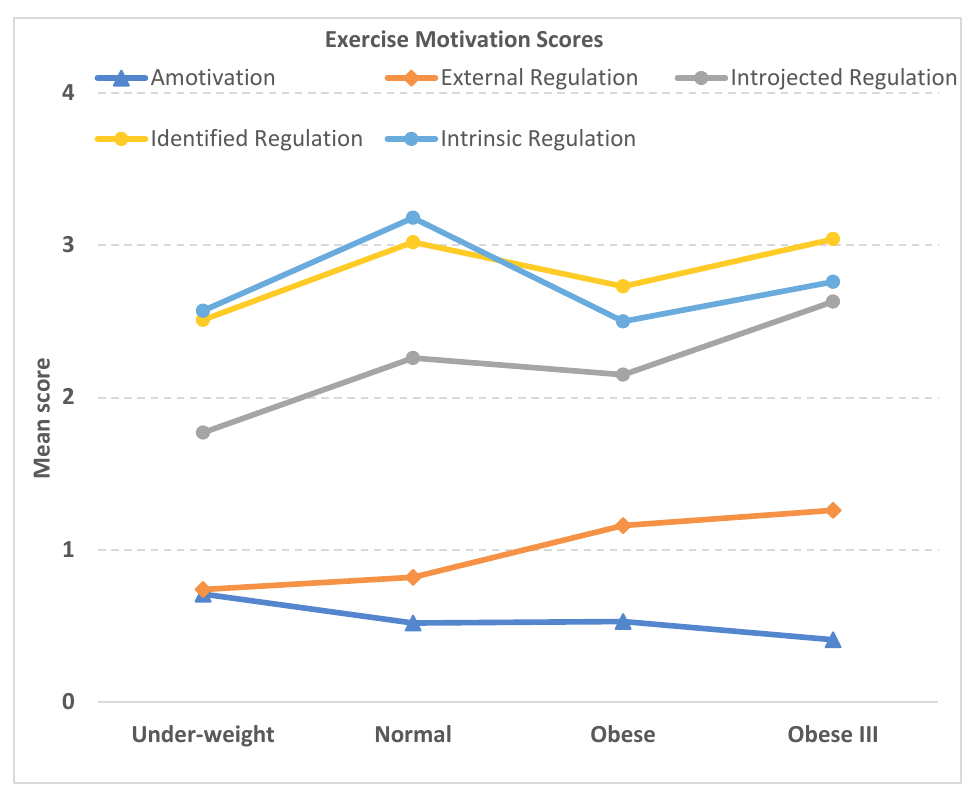
Figure 1. Mean score of Exercise Motivation at Different Levels of Body Mass Index Table 3. Domains of Exercise Motivation by Duration of Physical Activity per